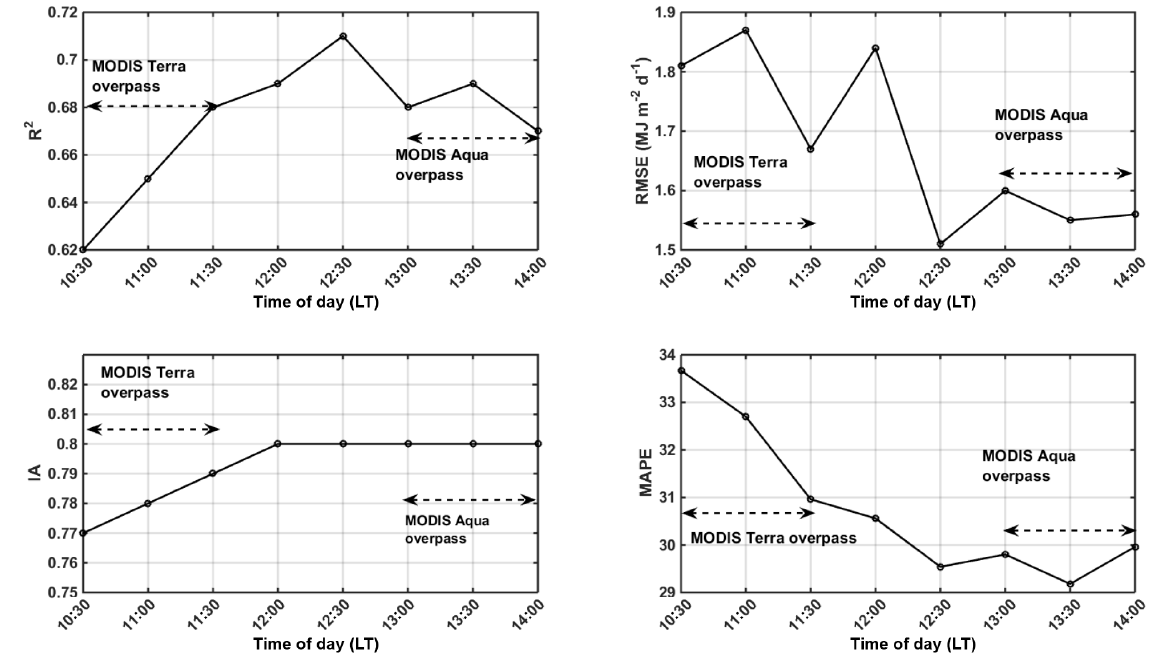
Figure 6. Statistical summary of ET d_pred for different times of day using Eq. (1) based on R Si and R Sd_pred . As the study is intended for remote sensing application, we once again demonstrate the potential of the method for future research in the case where satellite will be used and as such we pick MODIS Terra-Aqua overpass